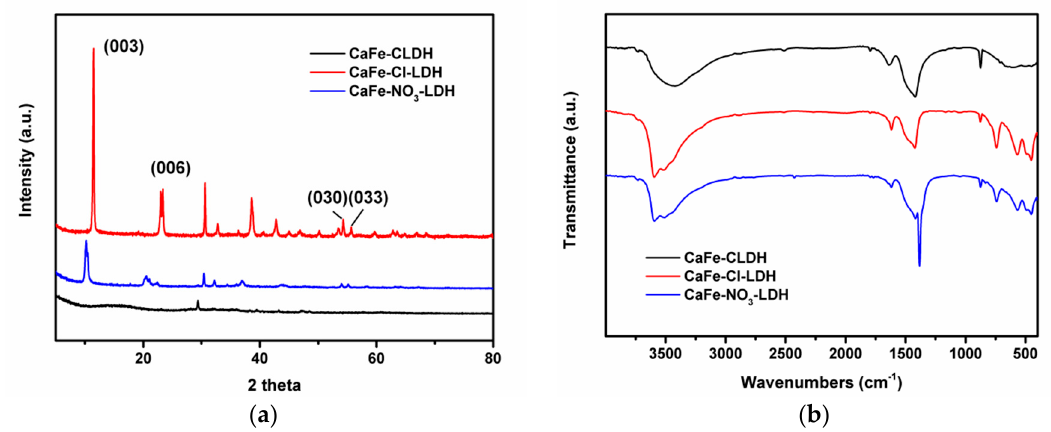
Figure 1. ( a ) XRD patterns of CaFe-NO 3 -LDH, CaFe-Cl-LDH and CaFe-CLDH. ( b ) Fourier Transfer Infrared (FTIR) spectra of CaFe-NO 3 -LDH, CaFe-Cl-LDH and CaFe-CLDH.